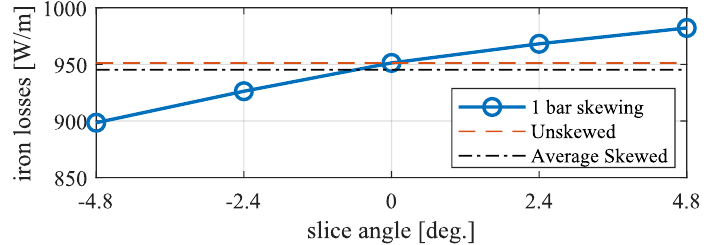
Figure 16. Variation of specific iron losses, considering several slice